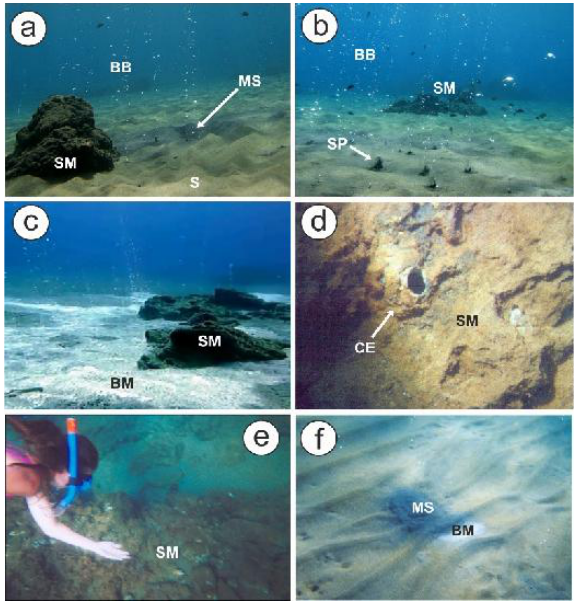
Figure 3. Features of hydrothermal venting through seafloor sediments (S) at Paleochori Bay: ( a – c ) shallow‐submarine venting associated with gas bubbles (BB) and the formation of metalliferous sediments (MS) and sulfide mounds (SM). The intensity of gas discharge is such that it raises sand plumes (SP). White bacteria mats (BM) are associated with venting (c). ( d ) Conical edifice (CE) (e.g., chimney) (approximately 3 cm diameter) discharging high‐salinity liquids and no gas within an irregular shaped sulfide mound, from the hydrothermal fallout (photograph from Valsami‐Jones et al. [41]); ( e ) sulfide mound (SM); ( f ) metalliferous sediments (MS), and white microbial mats (BM). Hydrothermal activity with associated sulfide mineralization is concentrated in the center of the bay (Figures 2c and 3). Intense streams of gas bubbles (Figure 3a–c) and high salinity liquid discharge (Figure 3d) emerge through the sandy seafloor or between sulfide mounds and conical edifices. According to Valsami‐Jones et al. [41], venting associated with the formation of sulfide mounds from the hydrothermal fallout is also related to in- termittent gas bubbling through the mound structure. Occasionally, the intensity of vent- ing associated with gas bubbles is such that it raises grey to black sand plumes (fluid plumes with entrained sand) (Figure 3b).